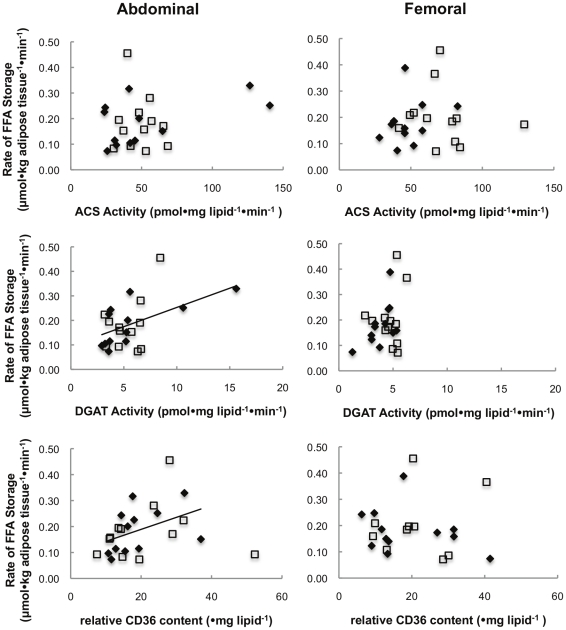
Physiological relationship between regional FA storage factors vs. regional FFA storage.Regional rates of FFA storage (µmol•kg adipose tissue−1•min−1) vs. lipogenic protein activity expressed per mg lipid. ♦represents T(+) men, □represents T(−) men, —represents a significant correlation in T(+) men.